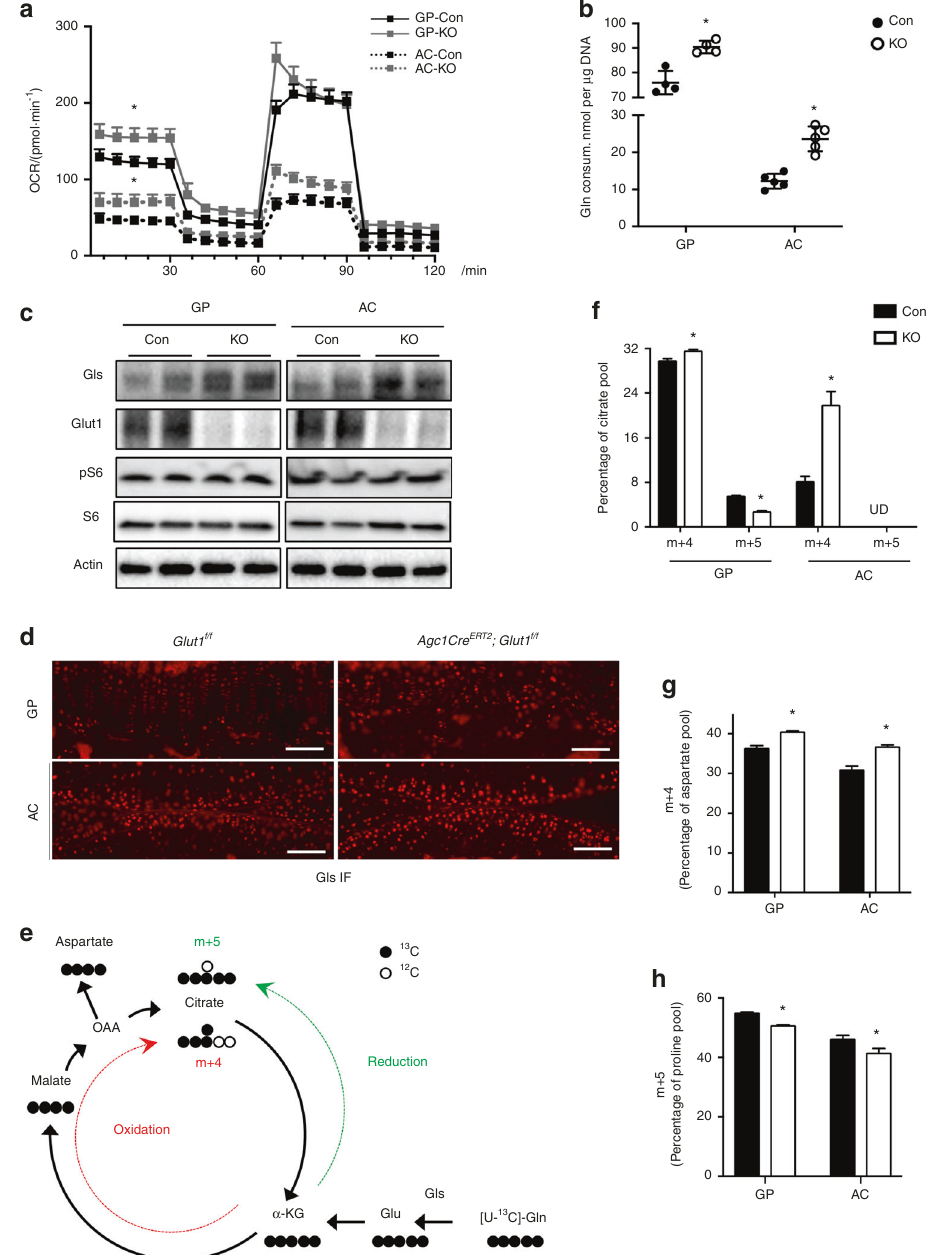
Fig. 6 Both GP and AC chondrocytes exhibit enhanced glutamine metabolism in the absence of glucose availability. a A Seahorse assay was used to assess the oxygen consumption rates (OCRs) of control and Glut KO primary GP and AC chondrocytes. The data are the mean ± SD. N = 8. * P < 0.05 relative to the controls. b Glutamine consumption by control and Glut1 KO primary GP and AC chondrocytes for 24 h. The data were normalized to the genomic DNA content and are expressed as the mean ± SD. N = 5. * P < 0.05. c Western blot analyses of glutaminase (Gls), Glut1, pS6 and S6 protein levels in control and Glut KO primary GP and AC chondrocytes. N = 3. d Immuno fl uorescence staining for Gls in tibia and knee sections of control and Glut1 LOF mice at 2 months. N = 6. Scale bar, 100 μ m. e Graphical depiction of glutamine metabolism tracing with [U- 13 C] glutamine. The black fi lled circles denote 13 C, and the black open circles indicate 12 C. Gln glutamine, Glu glutamate, α -KG α -ketoglutarate, OAA oxaloacetate. Glutamine is converted to citrate through glutamine oxidation, as indicated by the red dashed line. The glutaminolysis pathway contains glutamine oxidation in the TCA cycle and the malate-aspartate shuttle. Glutamine can also be converted via reductive carboxylation, as denoted by the green dashed line. f – h Fractions of citrate m + 4 and m + 5 ( f ), aspartate m + 4 ( g ), and proline m + 5 ( h ) after culture of control and Glut KO GP and AC chondrocytes for 24 h with [U- 13 C] glutamine. The data are the mean ± SD. N = 3. * P < 0.05 compared to the hydroxylation to promote the formation of collagen triple helices, AC (Fig. 7e, f). Thus, our results show that in addition to enhanced glutamine-derived α -KG is likely a key metabolite responsible for glutamine-derived oxidative phosphorylation, Glut1 LOF chondro- the increased oxidative phosphorylation and collagen over- cytes also have increased prolyl hydroxylase activity. Since modi fi cation in Glut1 LOF mice. collagen P4h is an α -KG-dependent enzyme that catalyzes proline